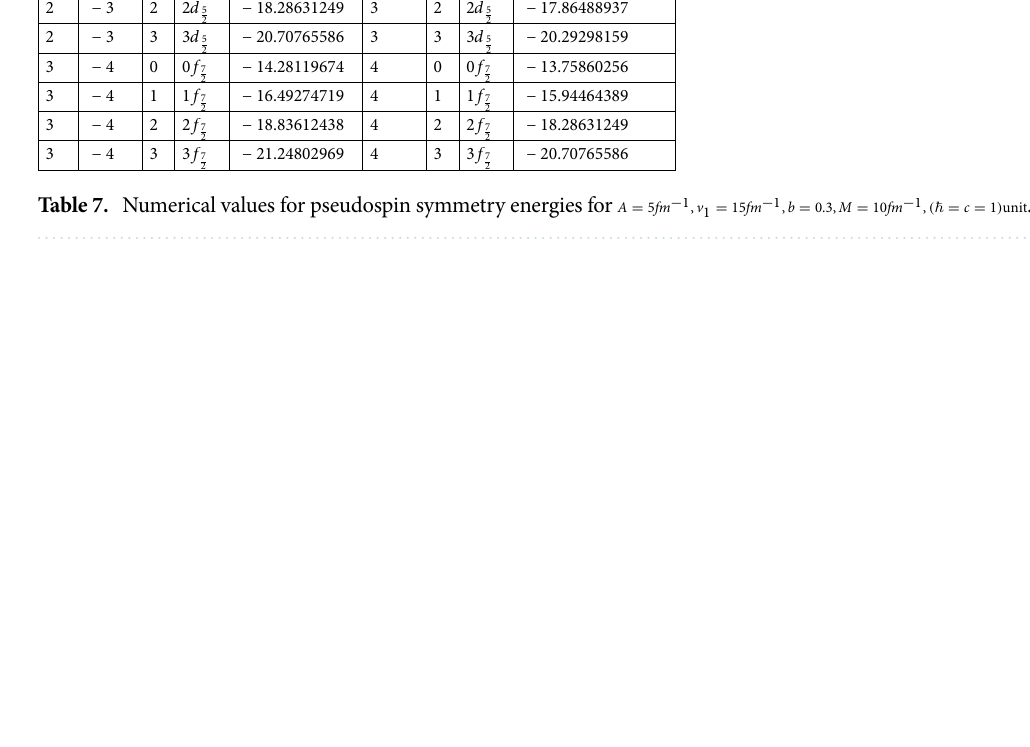
Table 7. Numerical values for pseudospin symmetry energies for A